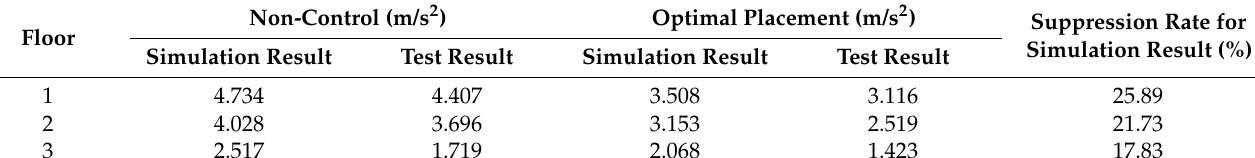
Table 7. Peak interlayer acceleration and corresponding suppression rates under optimal and uncontrolled conditions.